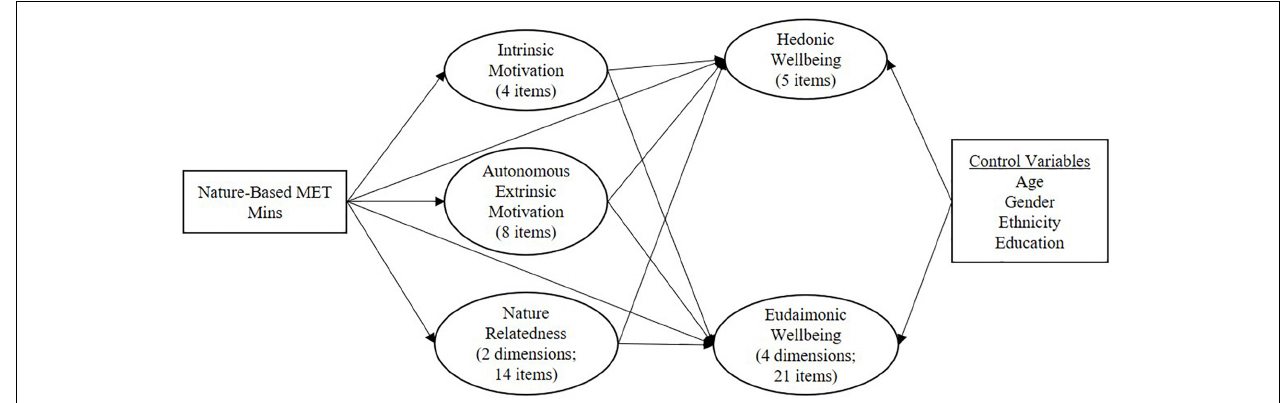
FIGURE 1 | Tested relationships amongst